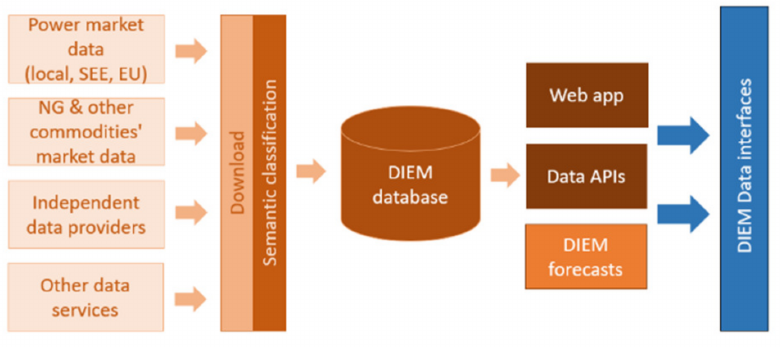
Figure 5. DIEM basic